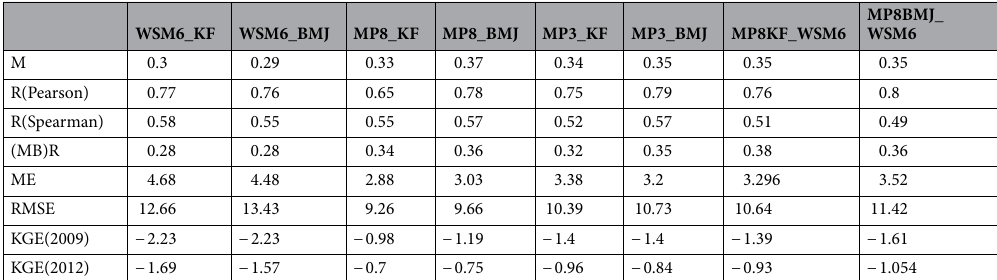
Table 4. Performance metrics for DJF of the simulations with